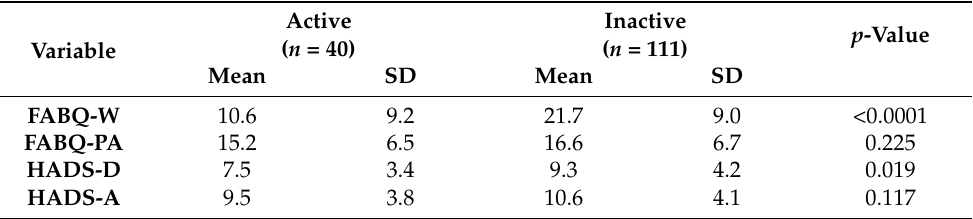
Table 4. Comparison of psychological characteristics of patients according to professional situation.